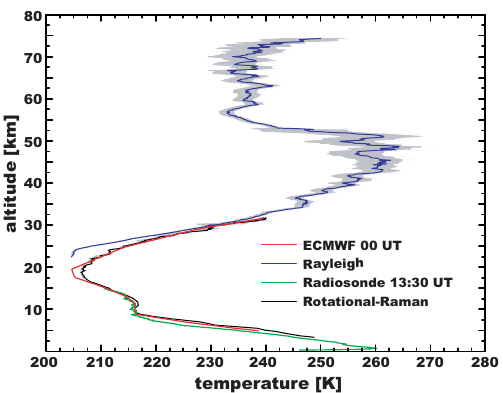
Fig. 4. Temperature profile between 5 and 75km measured at Es- range between 13:39UT on 14 January 2011 and 08:36UT on 15 January 2011. Profile were obtained using the integration tech- nique (blue) and the rotational-Raman technique (black). The gray shaded area shows the error range. For comparison the tempera- ture profiles measured with radiosonde (green) and given by the ECMWF re-analysis (red) are shown as well.